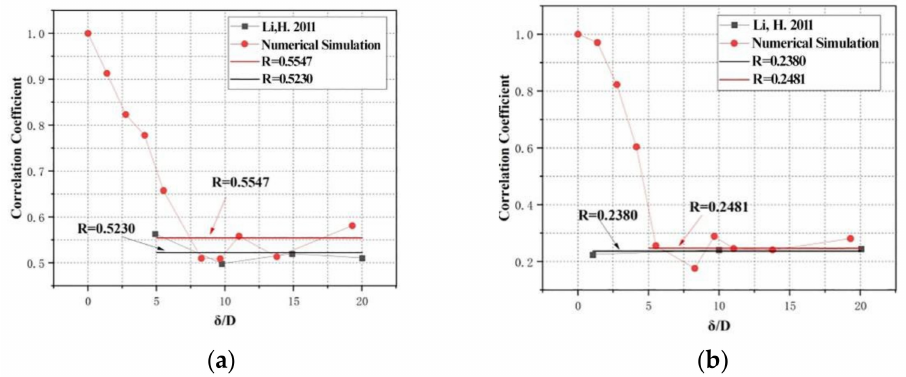
Figure 16. Spanwise correlation of pressure coefficient in wake region of downstream section of bridge of numercial simulation and Li, H.’s measurement [26]. ( a ) Spanwise correlation of pressure coefficient of an upper surface; ( b ) Spanwise correlation of pressure coefficient of a lower